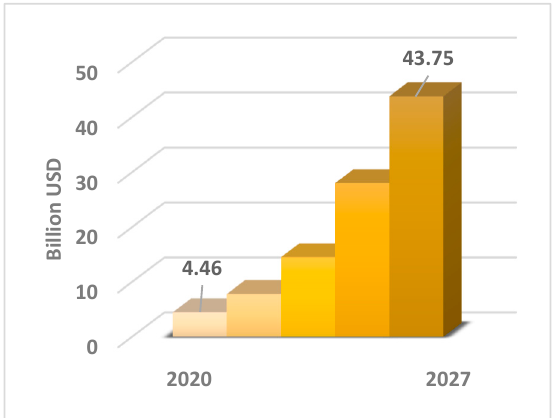
Figure 4. Forecasted size of global hemp fibre market up to 2027 based on [15].